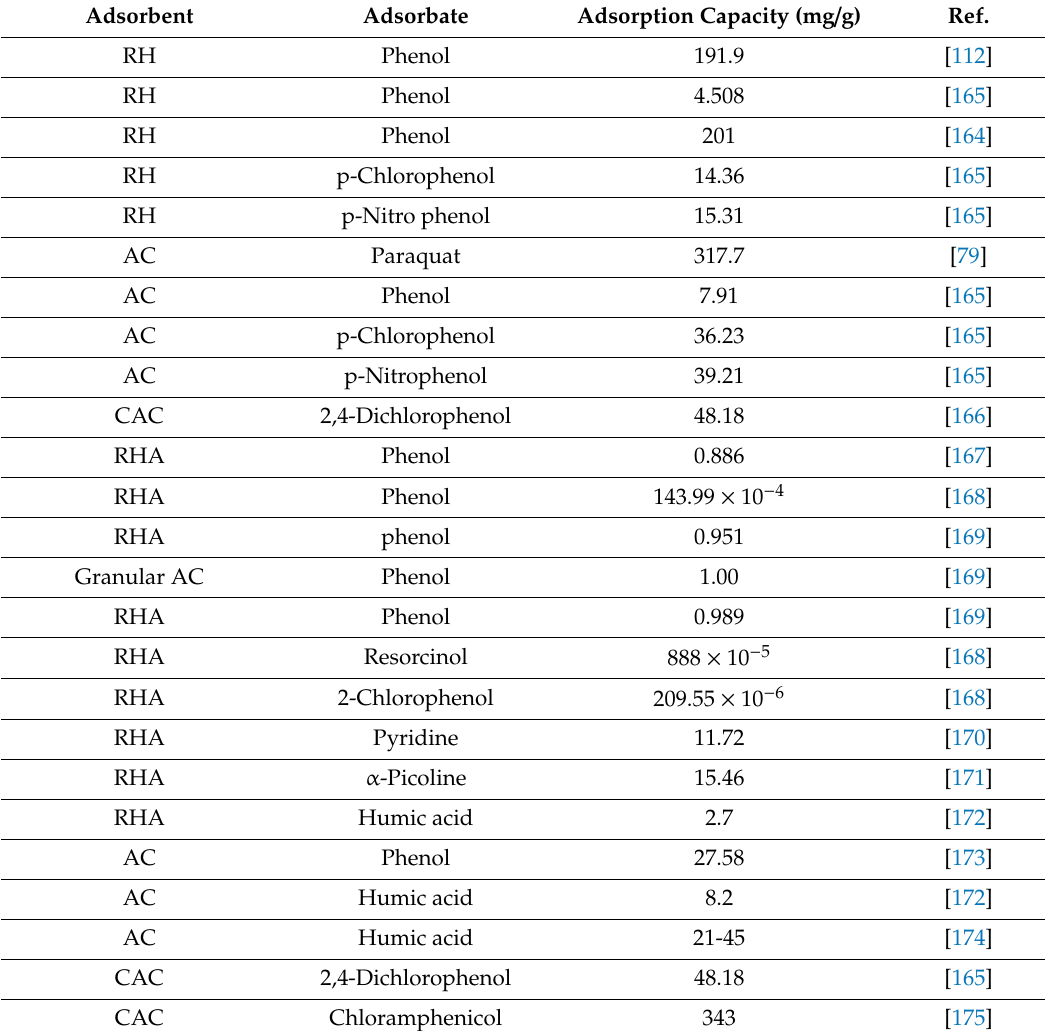
Table 7. Adsorption capacities of phenols and other organic compounds by pristine rice husk (RH), RH ash (RHA), and RH-derived